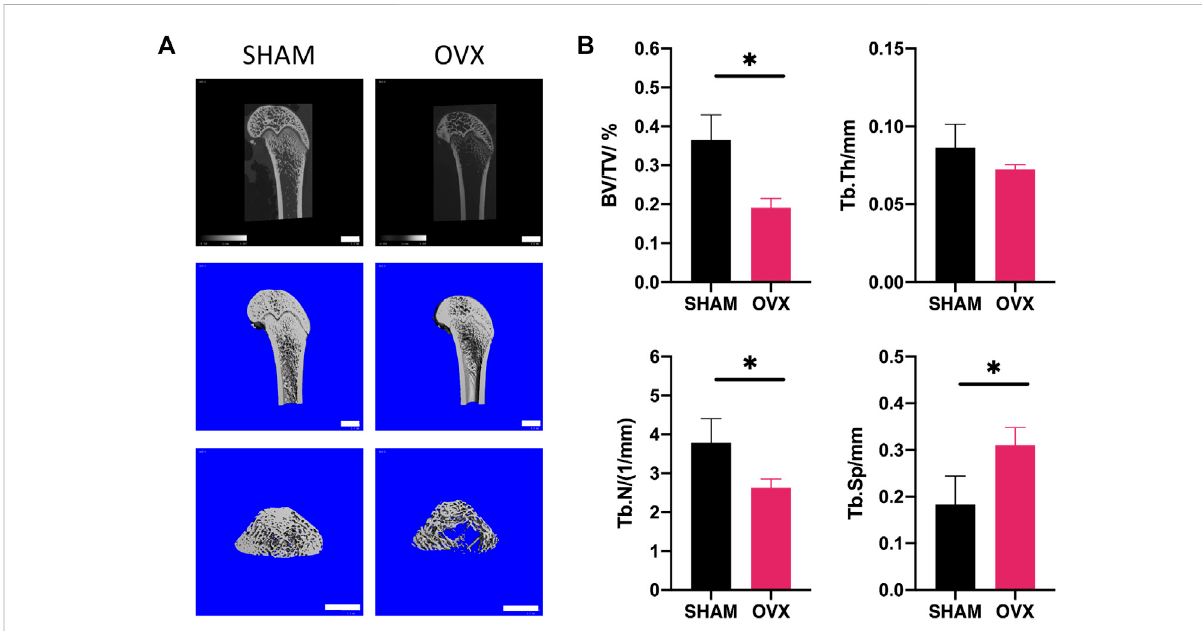
FIGURE 3 EstablishmentofOVXratmodelforosteoporosis.OVXwasperformedat12 weeksusingmicro-CTscanningtovalidateboneconditions. (A) 3D representative micro-CT micrographs of femoral condyles in the OVX and sham groups. Scale bars: 2 mm. (B) Quantitative parameters used to assess morphological bone alterations such as trabecular bone volume percentage (BV/TV), trabecular thickness (Tb.Th), trabecular number (Tp.N) and trabecular separation (Tb.Sp) ( n = 6). Asterisks represent signi fi cant differences among groups (* p <